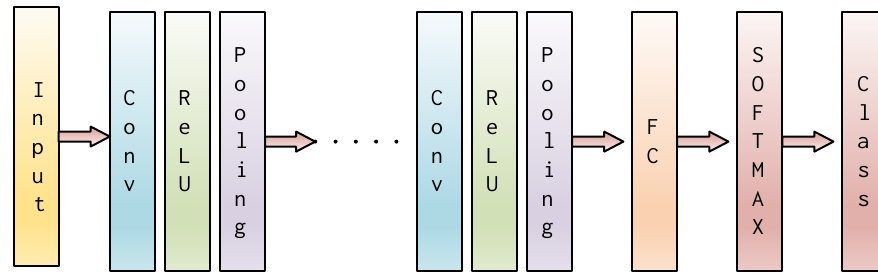
Figure 3. General structure of convolutional neural network.